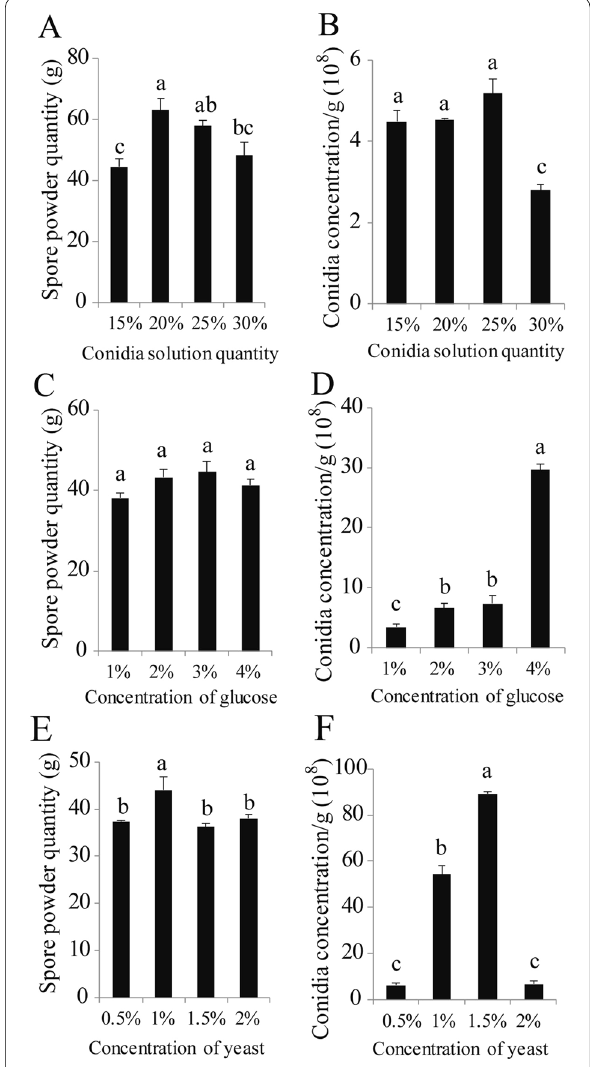
Fig. 4 Effects of conidial solution quantity ( A , B ), glucose concentration ( C , D ), and yeast concentration ( E , F ) in liquid media on spore powder quantity ( A , C , E) and conidial concentration ( B , D , F ) in the final product. Bars with same letters were not significantly different according to Duncan’s